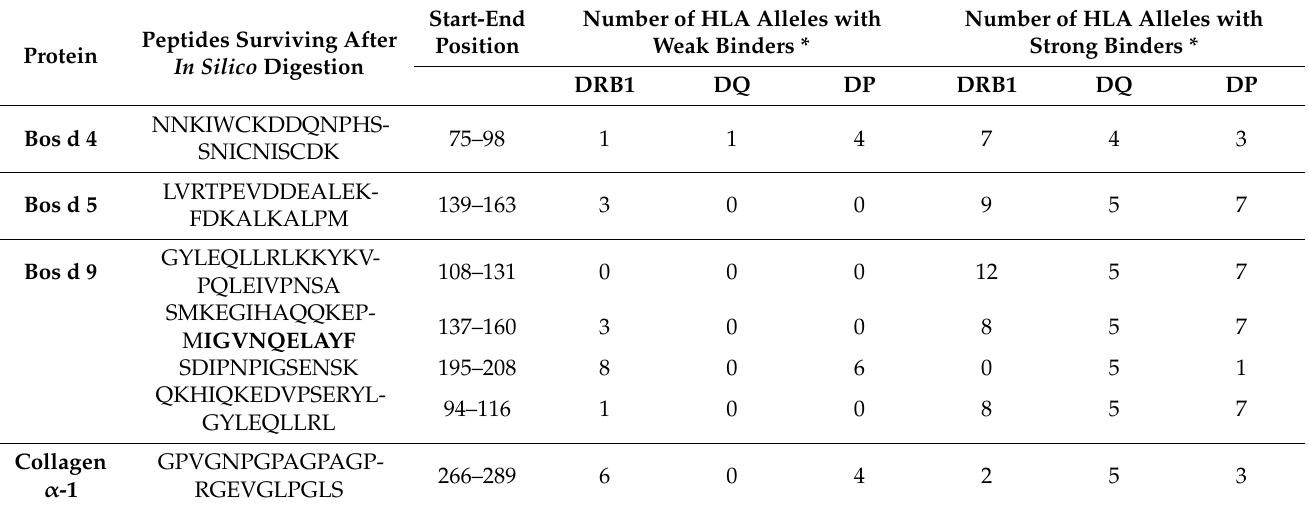
Table 3. IS antigenicity assessment of IV digested peptides with major MHC II alleles according the EpiTOP3 tool.